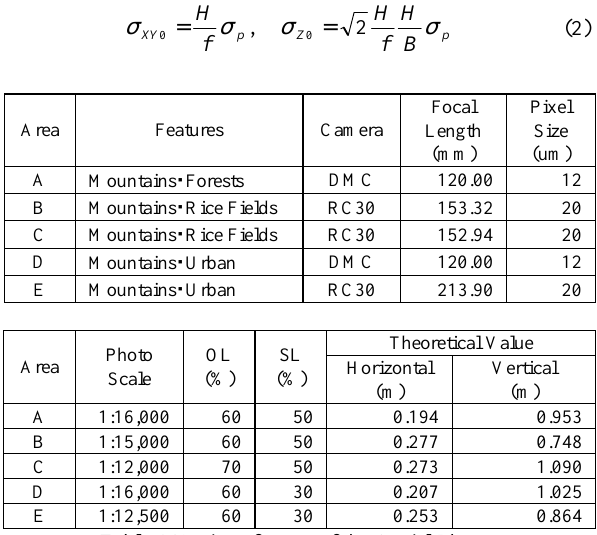
(b) stereo models in the current strip, and (c) stereo models in